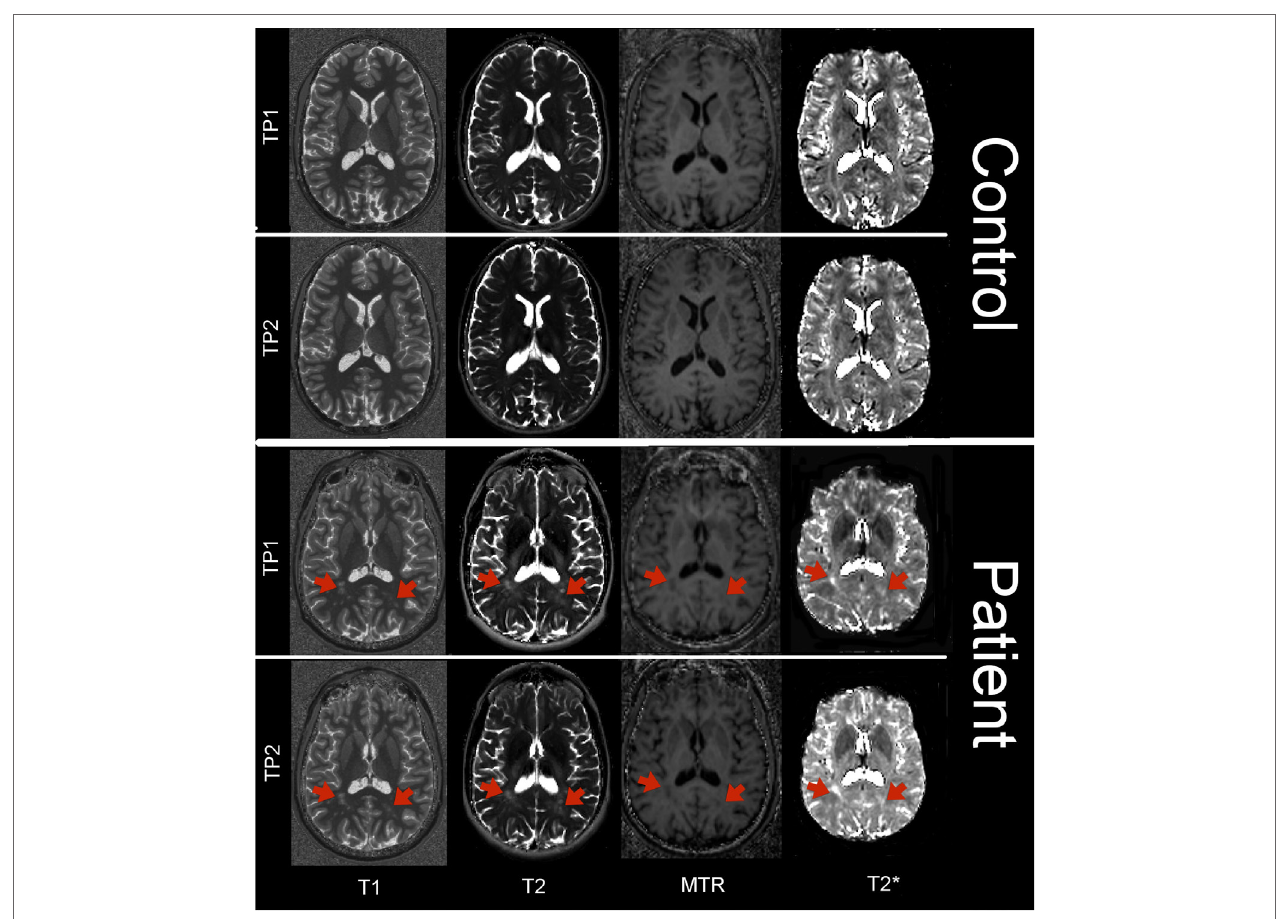
FigUre 1 | Axial view of T1 map, T2 map, T2* map, and MTR in a control and in a patient at time-point 1 and 2. Red arrows point at the location of MS lesions.